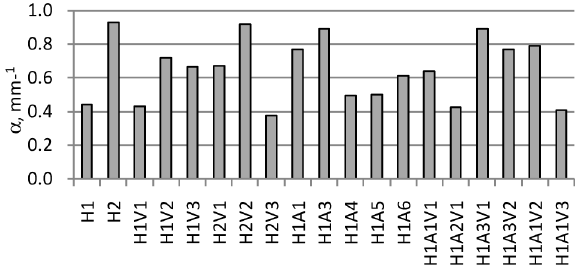
Fig. 3. The air-void specific surface of HPSCC (Łaźniewska- Piekarczyk